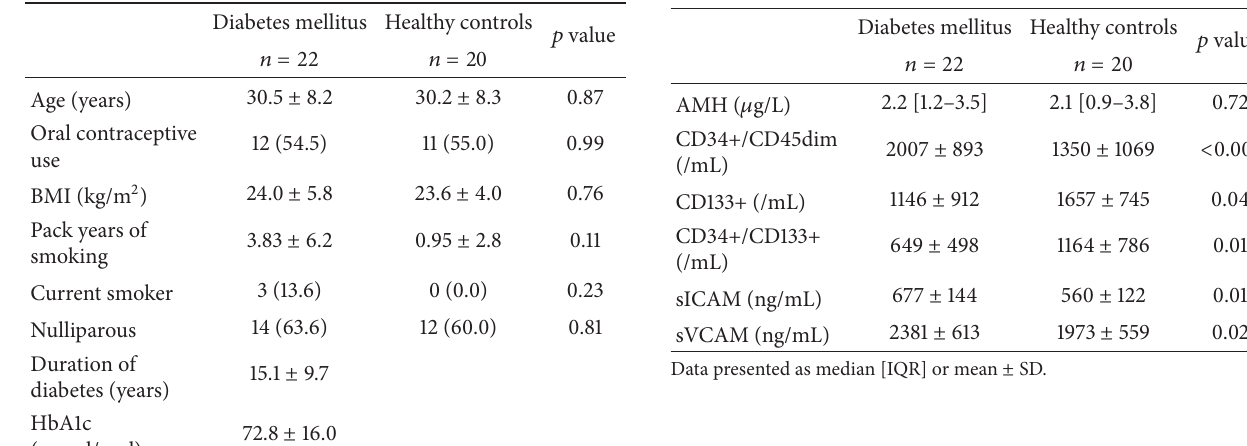
Table 2: Outcomes for DM-1 versus healthy controls.